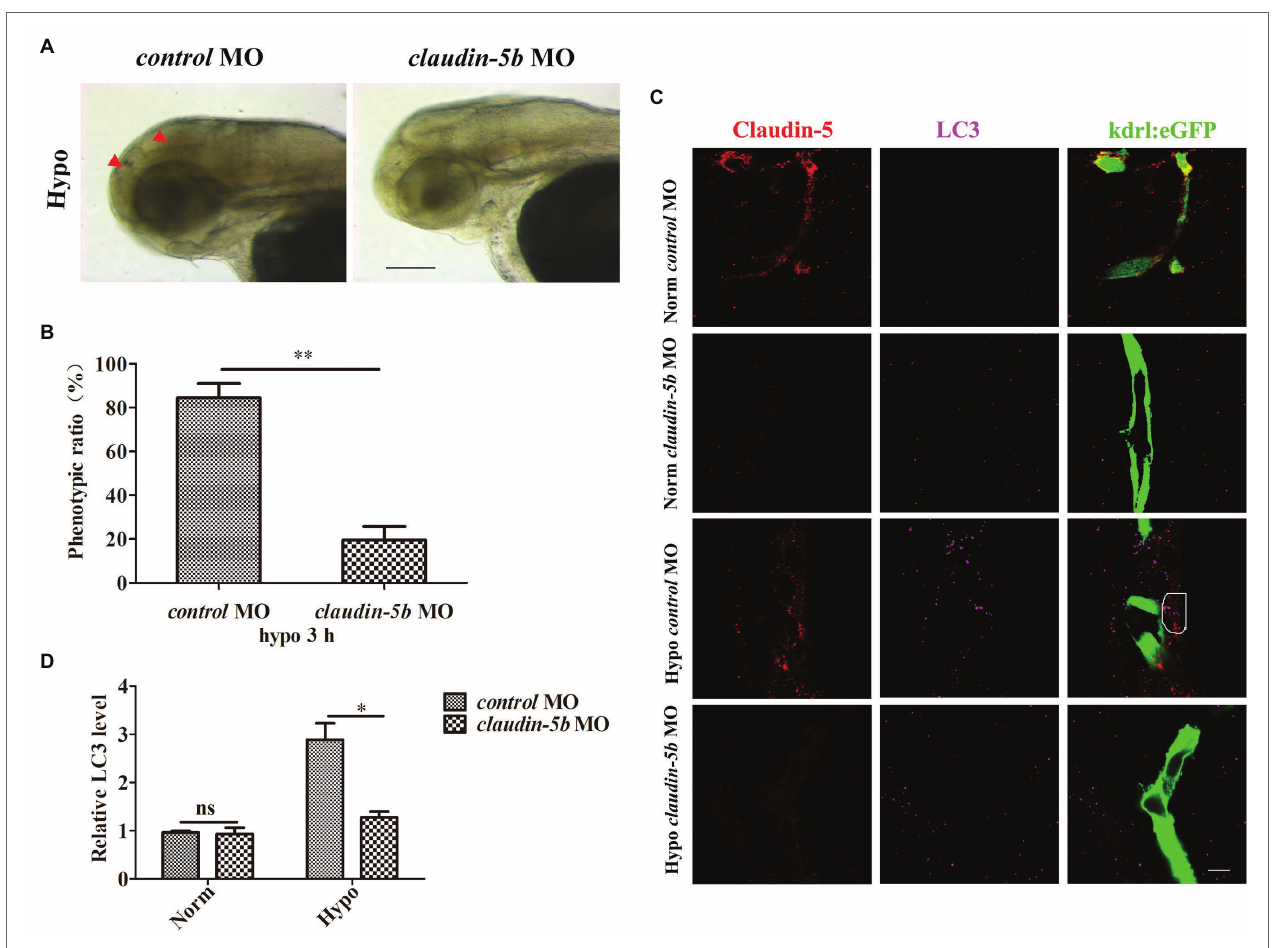
FIGURE 2 | Loss of Claudin-5b in zebrafish embryos inhibits activation of autophagy in cerebrovascular endothelial cells (ECs). Morpholino (MO) silencing of claudin-5b in endothelial eGFP-specific transgenic Tg ( kdrl:eGFP ) zebrafish embryos. (A) Brain phenotype (red arrowheads) of control MO and claudin-5b MO zebrafish larvae in response to hypoxia. Scale bar, 100 μ m. (B) Quantitative analysis of the severe injury rates of control MO and claudin-5b MO zebrafish larval brains. Mean ± SD, n = 3 independent experiments per group. (C) Confocal microscopy images of Claudin-5 (red) and LC3 (purple). Scale bar, 5 μ m. (D) Quantitative analysis of LC3 levels by Image-Pro Plus. Mean ± SD, n = 3 independent experiments per group. * p < 0.05 and ** p <